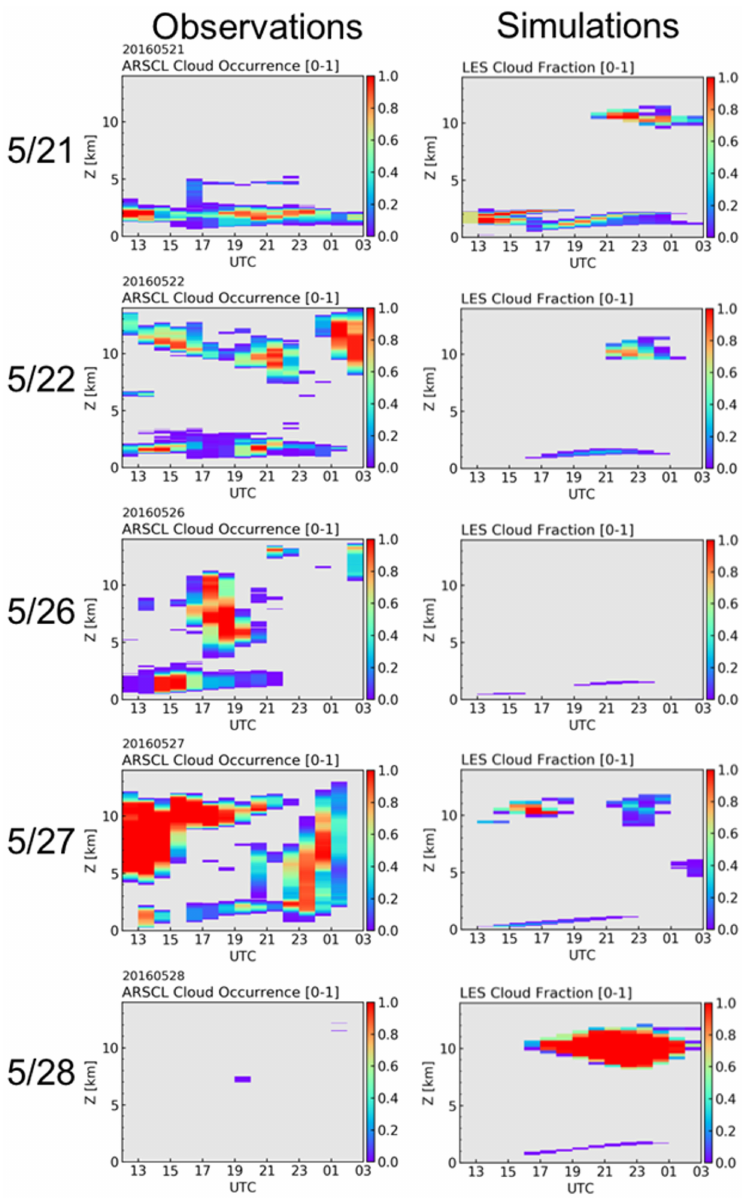
Figure 4. Time variations of cloud occurrence profiles from Active Remote Sensing of Clouds (ARSCL) measurement ( left ) and Large-Eddy Simulation (LES) (right) for 21, 22, and 26–28 May. The horizontal axis represents the hour of the day (UTC), and the left vertical axis represents the height in km. Color represents, for ARSCL, the fraction of clouds observed by vertically pointed remote sensors during an hour and, for LES, the fraction of clouds in the model domain averaged over an